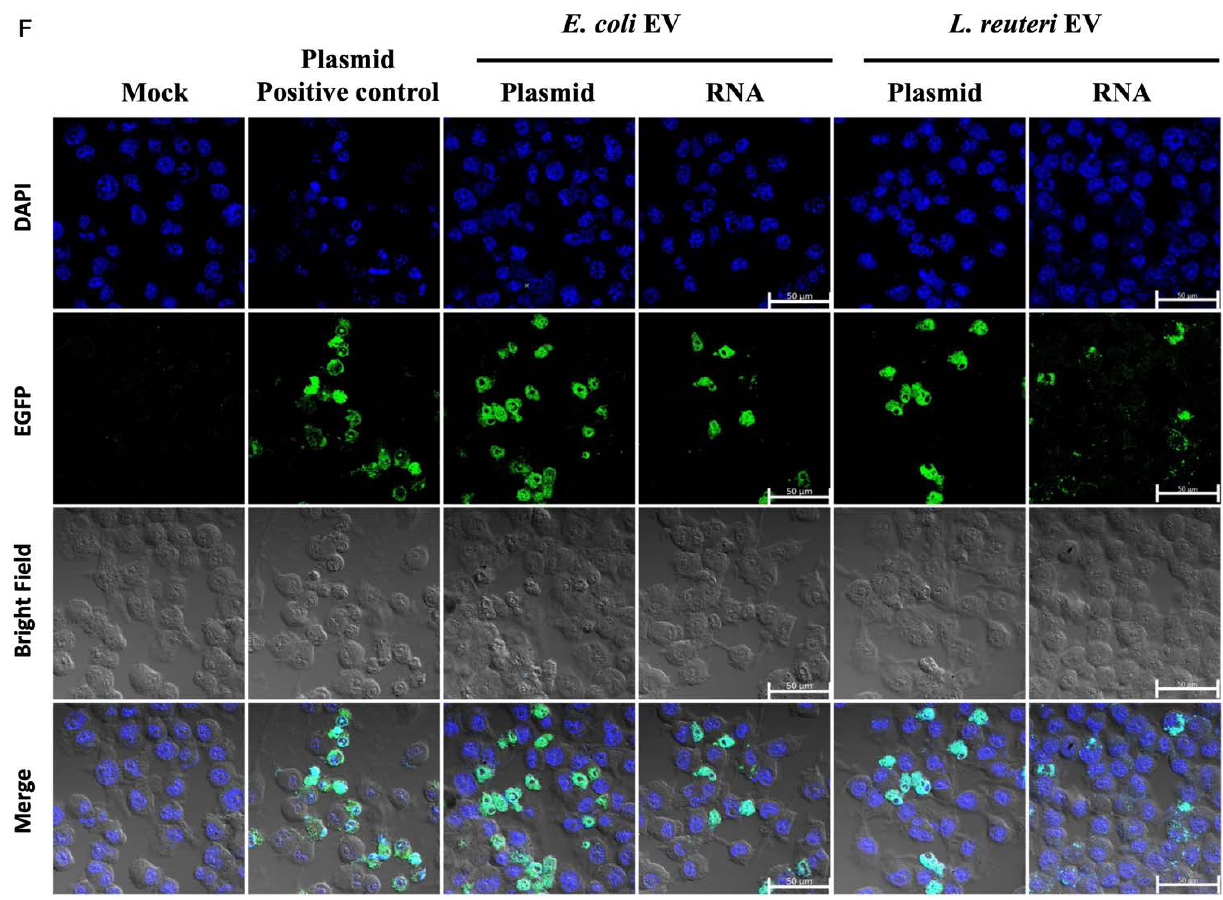
Figure 1. Bacterial extracellular vesicles (bEVs) can transfer exogenous plasmid or RNA to mamma- lian host cells (BV2). ( A ) Analysis of bEVs from Escherichia coli (top) and Lactobacillus reuteri (bottom) was performed using the NanoSight system to show the size distribution ( X -axis) and particle num- bers ( Y -axis). ( B ) Schematic diagram of the experimental procedure. Enhanced green fluorescent protein (EGFP) plasmid or synthetic EGFP RNA was electroporated into EVs isolated from E. coli or L. reuteri followed by treatment with nucleases to remove the remaining plasmid DNA or RNA. ( C ) Transmission electron micrograph of bEVs. The images show small vesicles of each bacteria in com- parison with bEVs after plasmid DNA or RNA electroporation. Scale bar, 300 nm. ( D ) Cell viability assay after treatment with bEVs. MTT assay was performed to investigate the effect of E. coli and L. reuteri EVs on cell viability. These results are from three independent experiments; each bar repre- sents standard deviation. ( E ) RT-PCR was performed to verify plasmid DNA or synthetic EGFP RNA transferred by bEVs. ( F ) Delivery of EGFP DNA or RNA into BV2 cells. The bEVs were elec- troporated with the EGFP plasmid DNA or RNA. BV2 cells were incubated with E. coli (approxi- mately 8.4 × 10 7 particles; multiplicity of infection (MOI) of 84) and L. reuteri EVs (approximately 6.4 × 10 7 particles; MOI of 64) on a chamber slide for 24 h at 37 ℃ . The cells were counterstained with DAPI (blue) to visualize the nuclei. Positive controls were transfected with EGFP plasmid using Lipofectamine 2000. Confocal microscopy analysis of bEVs reveals colocalized bEVs and EGFP (overlay). Scale bar = 50 μm.